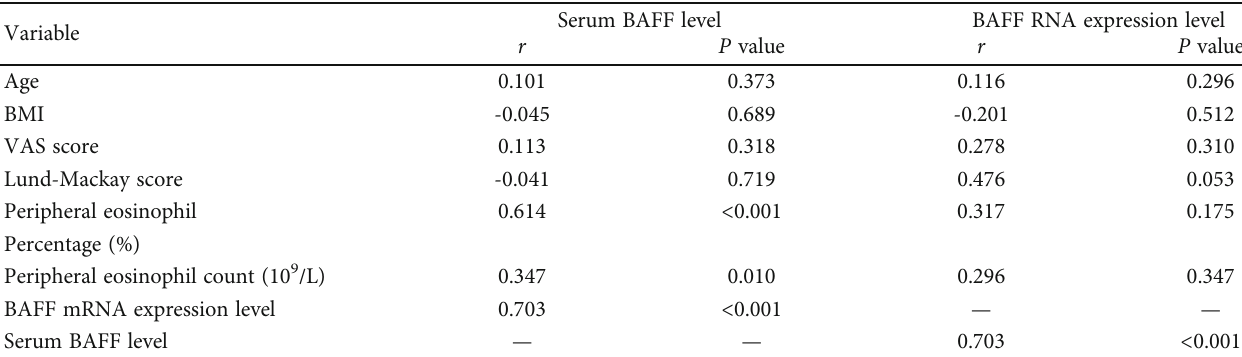
Table 3: Association between BAFF expression and clinical variables in CRSwNP